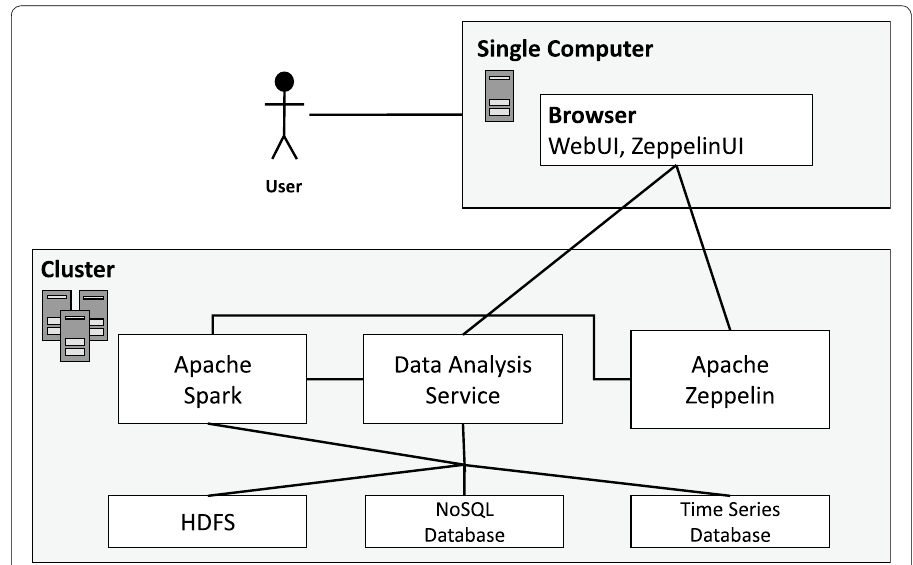
Fig. 2 Usage scenario of the Big Data forecasting